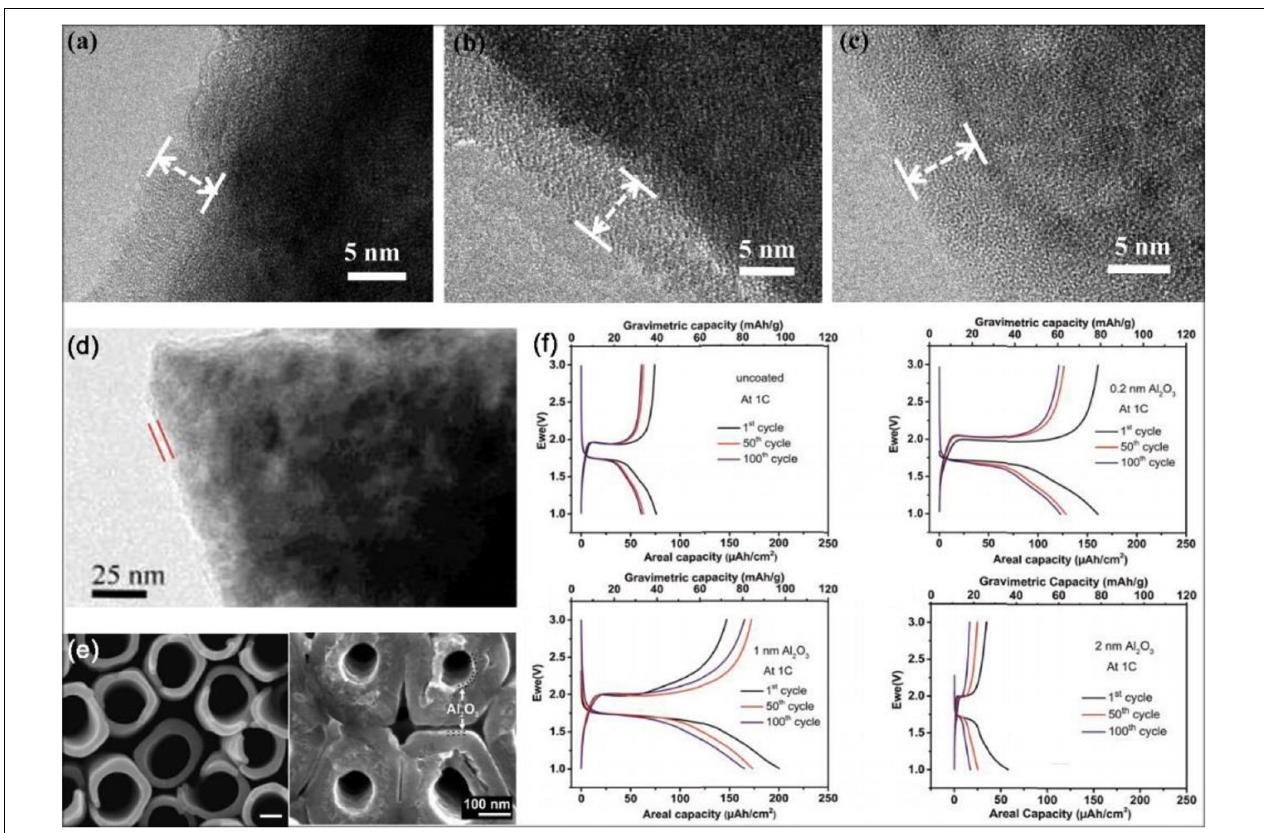
FIGURE 8 | The electrochemical performance of modified electrode materials by thin film deposition via ALD. (a–c) HRTEM images of the LiCoO 2 cathode by 50-ALD-cycles coating layers: TiO 2 , ZrO 2 , and Al 2 O 3 , respectively. Reproduced with permission from Ref. Li et al. (2014). Copyright 2014 Elsevier. (d) TEM image of CeO 2 ALD coated LiMn 2 O 4 particles after 100 cycles. Reproduced with permission from Ref. Patel et al. (2015). Copyright 2015 Wiley-VCH. (e) SEM images of a 10 nm Al 2 O 3 -coated TiO 2 nanotube layer. (f) Galvanostatic cycling at 1C rate of ALD Al 2 O 3 -coated TiO 2 nanotube with different cycling thickness. Reproduced with permission from Ref. Sopha et al. (2017). Copyright 2017 American Chemical